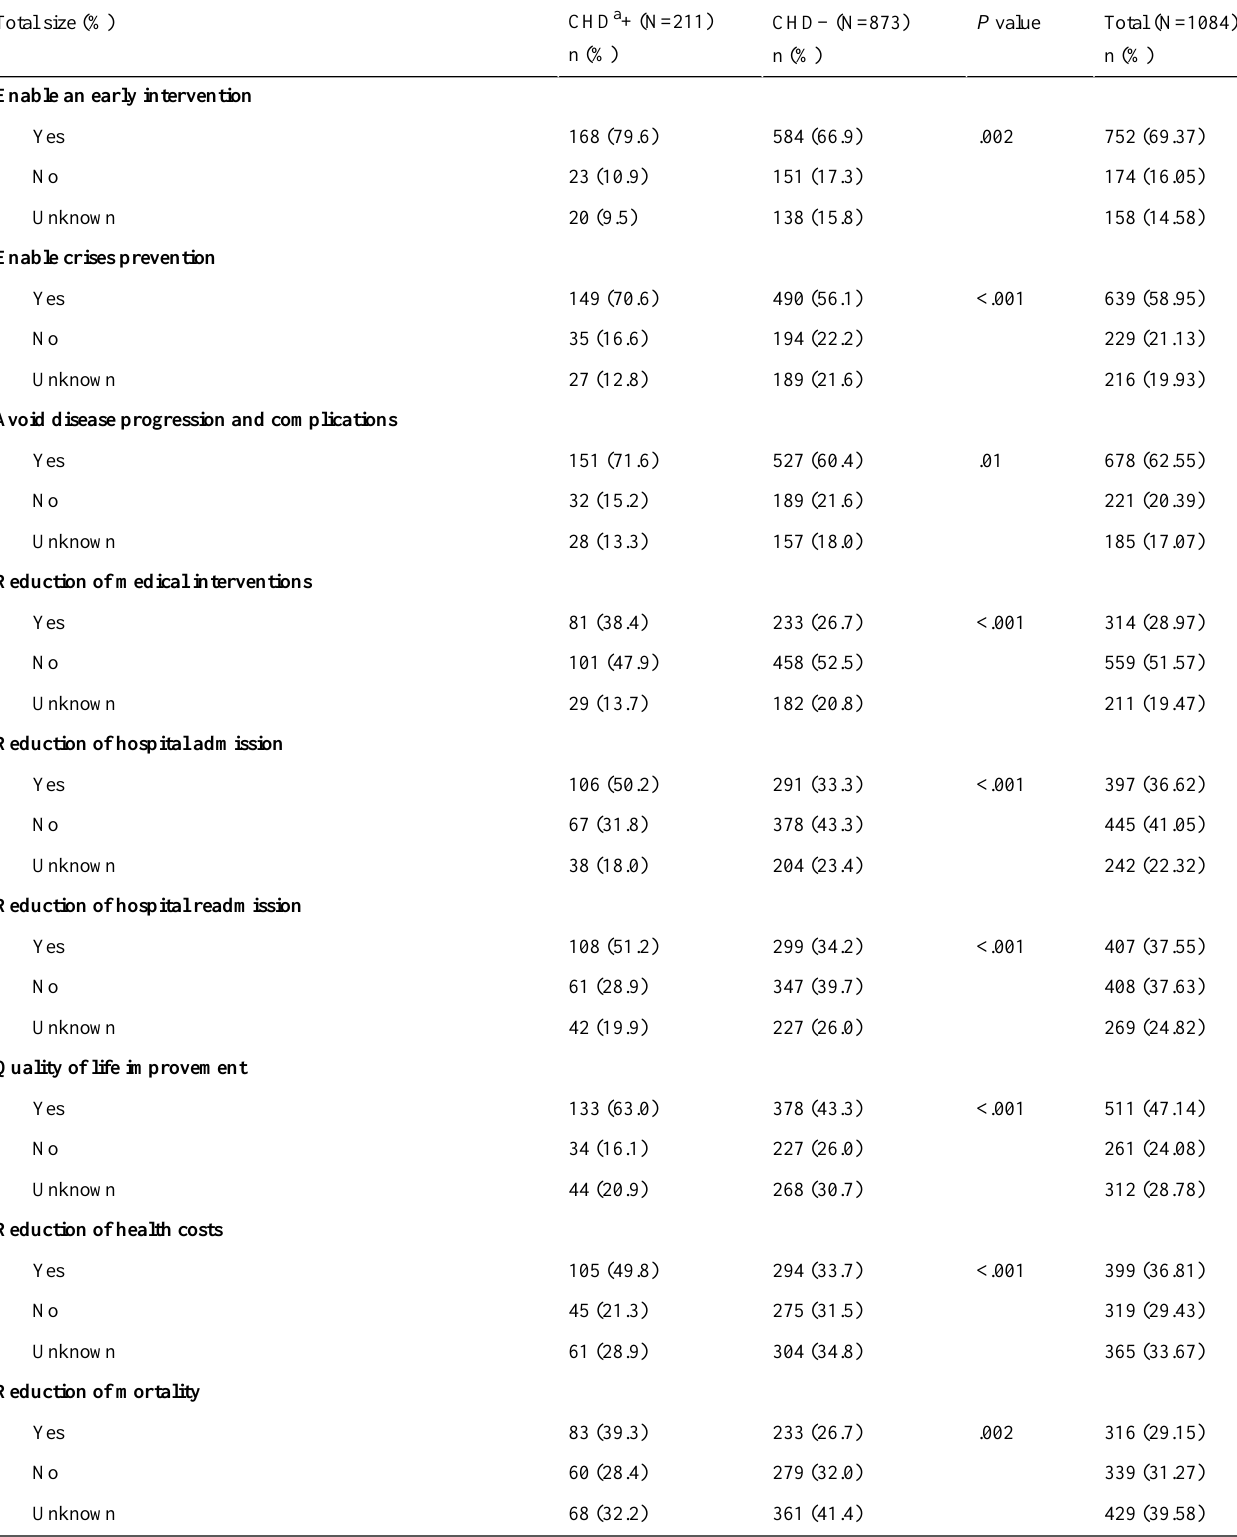
Table 3. Current or future usefulness of connected health devices (CHD) according to general practitioners (GPs;